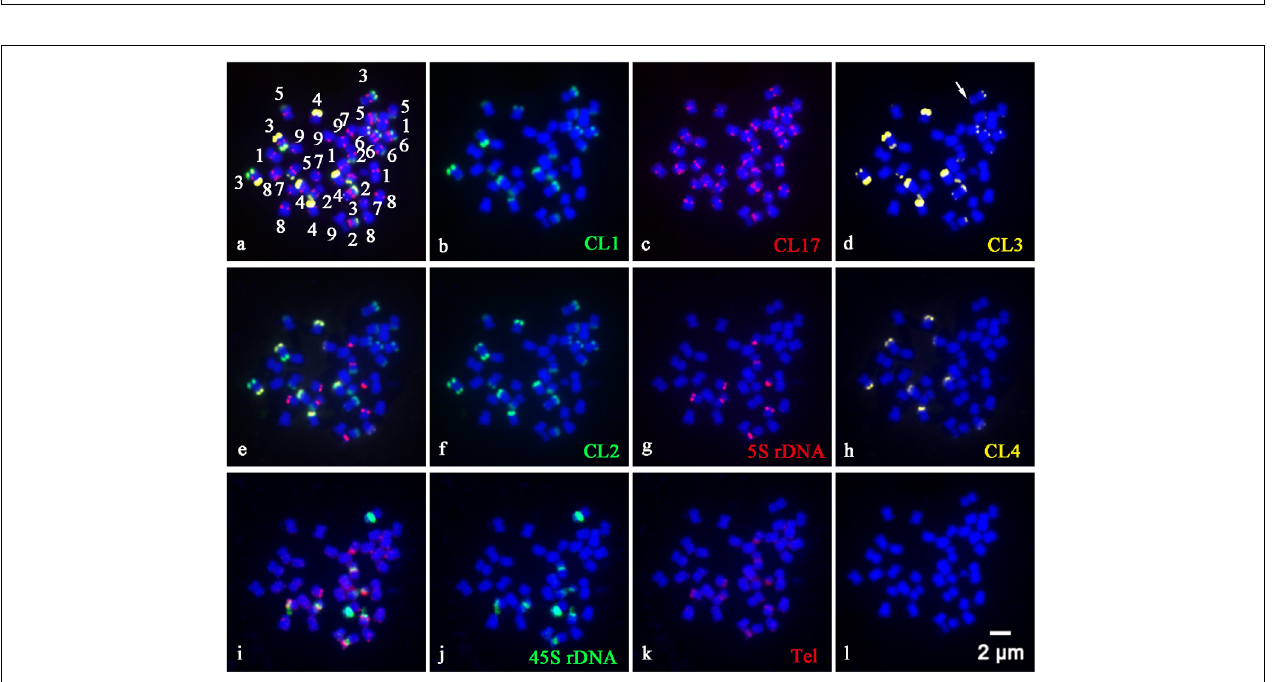
FIGURE 2 | Physical localization of different highly repetitive DNA sequences on root tip metaphase chromosomes of tetraploid Carrizo Citrange rootstock. The merged images of (a) , (e) , and (i) came from the hybridization sites in (b–d) , (f–h) , and (j,k) , respectively. (b) Satellite repeat CL1 (green), (c) a centromere-like repeat CL17 (red), (d) satellite repeat CL3 (yellow), (f) satellite repeat CL2 (green), (g) 5S rDNA (red), (h) satellite repeat CL4 (yellow), (j) 45S rDNA (green), and (k) telomere repeat (red) were used as FISH probes. Signal color corresponds to probe name in (b–d,f–h,j,k) . (l) DAPI-stained chromosomes were converted into a blue image. Bar = 2 µ